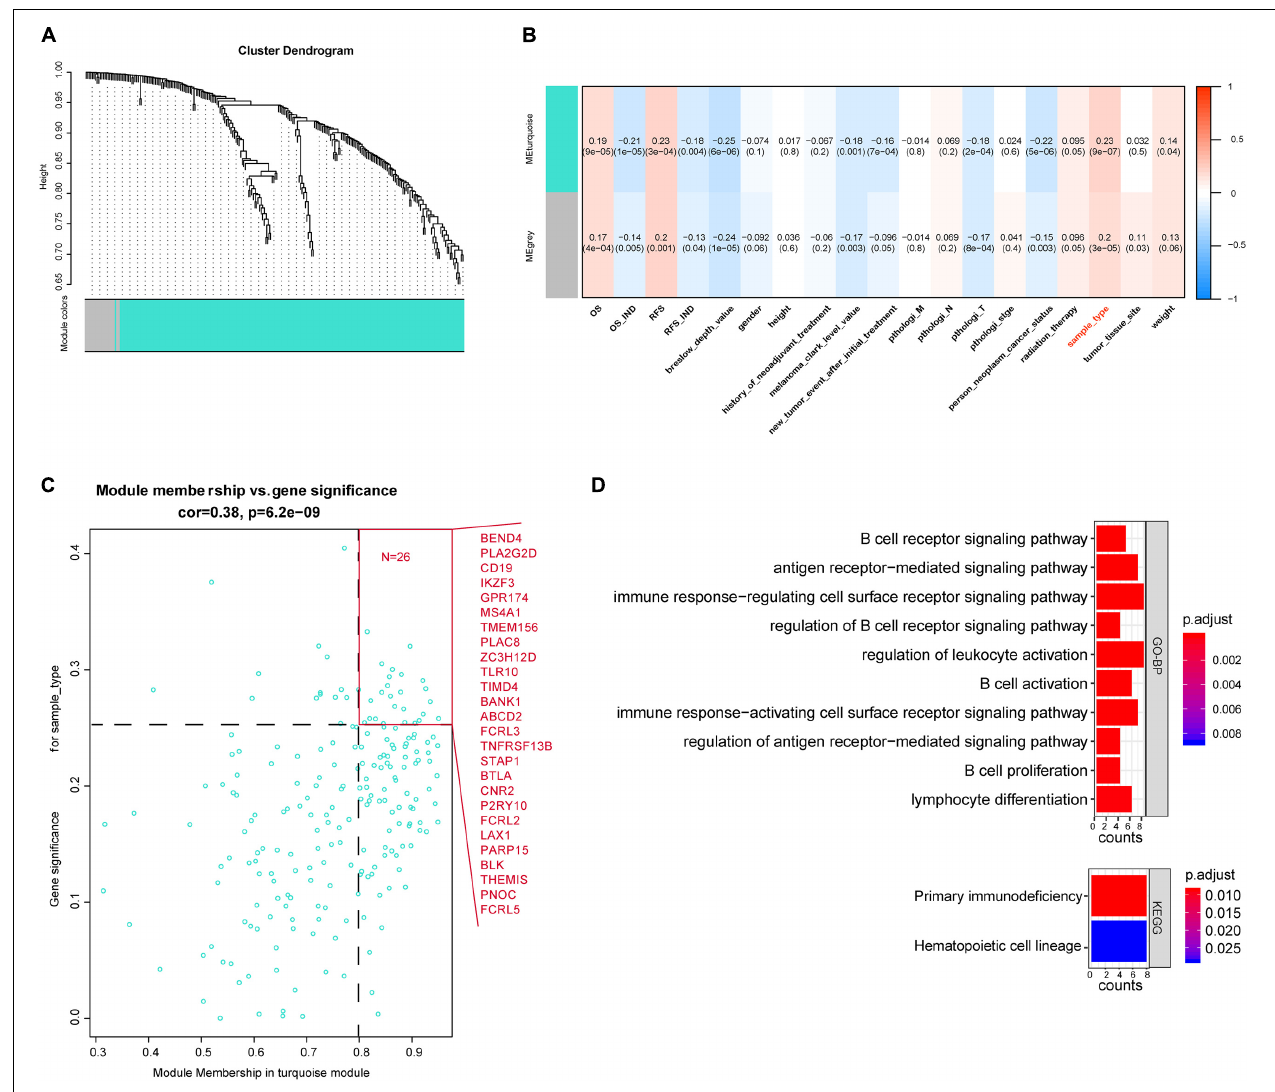
FIGURE 3 | Weighted gene co-expression network analysis (WGCNA) of immune-associated DEGs. (A) Cluster plot of genes based on the topological analysis of WGCNA. It shows that these immune-associated DEGs had two expression patterns. (B) Relationships between the module and clinical traits. Each cell described the relationship coefficients and P -values. (C) The gene significance and module membership of the blue module associated with metastasis. Hub genes are shown in red front. (D) Kyoto Encyclopedia of Genes and Genomes and Gene Ontology analysis of metastasis-associated hub